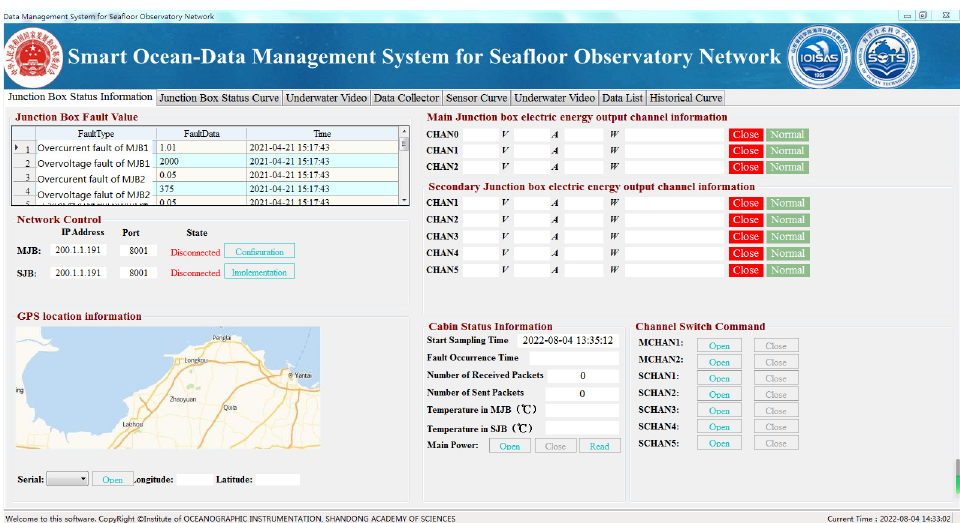
Figure 10. The typical main interface of SON-MS.